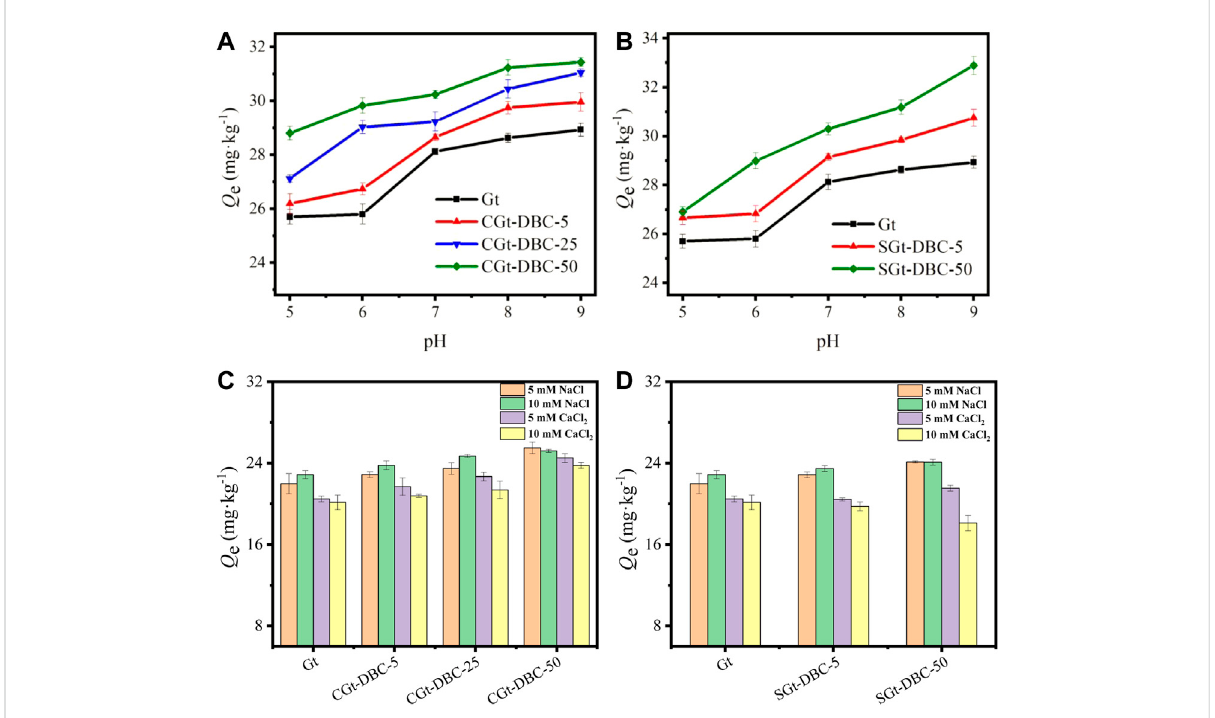
FIGURE 9 Effect of pH (A,B) and ionic species and strength (C,D) on adsorption of Gt and Gt-DBC samples to imidacloprid (CGt-DBC, the coprecipitated Gt-DBCcomplexes;SGt-DBC,theadsorbedGt-DBCcomplexes;NumbersindicatetheadditiveconcentrationofDBCinthepreparationofGt-DBC samples; Q e is the equilibrium concentration of IMI in the solid